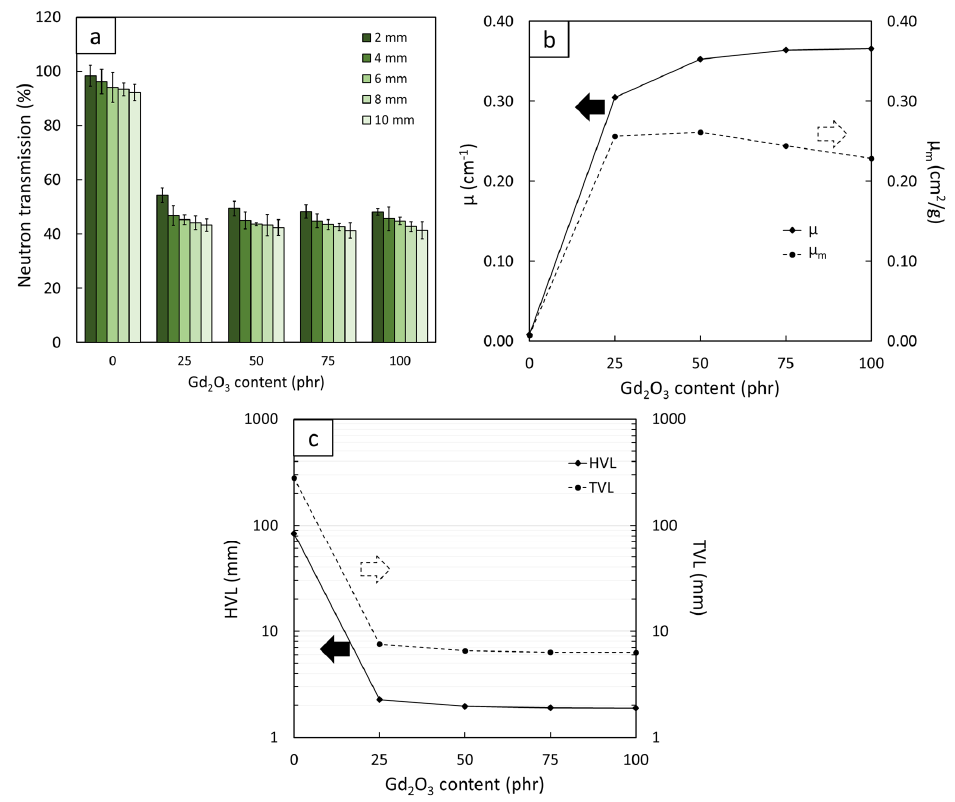
Figure 4. Neutron-shielding properties: ( a ) the neutron transmission, ( b ) linear attenuation coefficient (µ), mass attenuation coefficient (µ m ), ( c ) half-value layer (HVL) and tenth-value layer (TVL) of Gd 2 O 3 /NR composites containing varying Gd 2 O 3 contents of 0, 25, 50, 75, and 100 phr, where error bars indicate ± standard error.